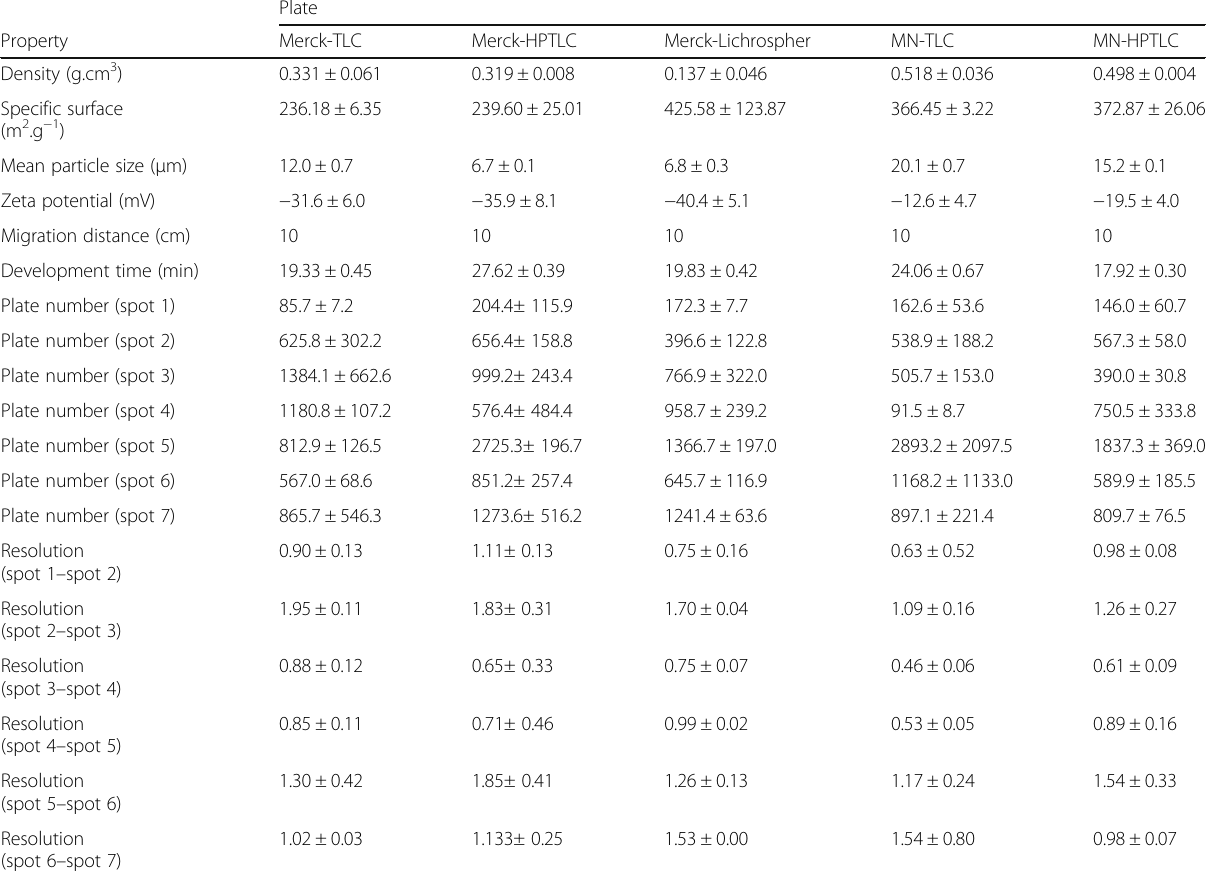
Table 1 Physicochemical properties of silica gel-coated Merck-TLC, Merck-HPTLC, Merck-Lichrospher, MN-TLC, and MN-HPTLC plates